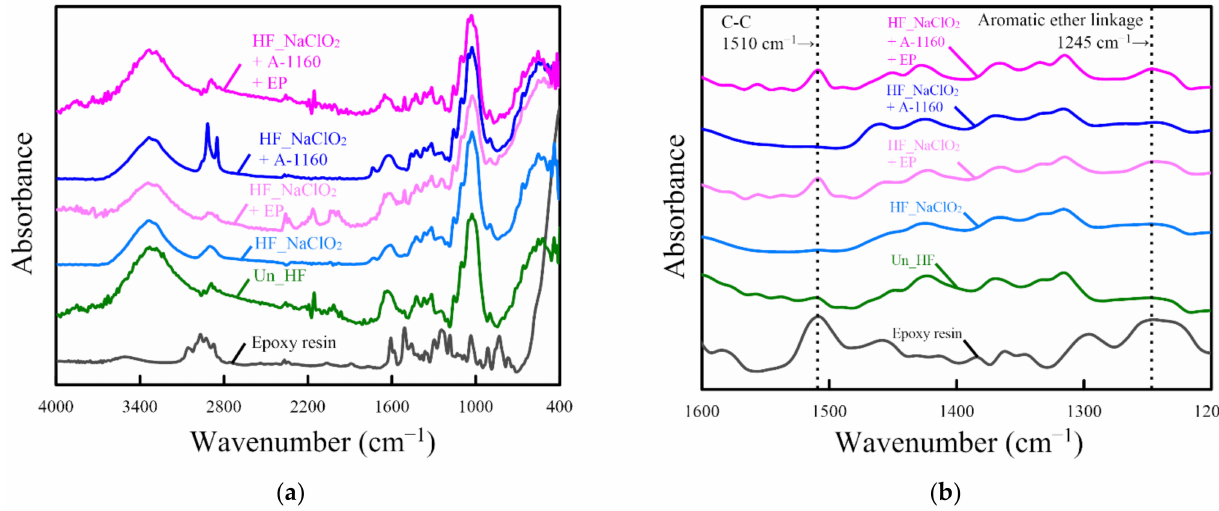
Figure 1. Fourier-transform infrared (FT-IR) spectrum of various surface-treated hemp fibers: ( a ) peak located at 400–4000 cm − 1 and ( b ) peak located at 1200–1600 cm − 1